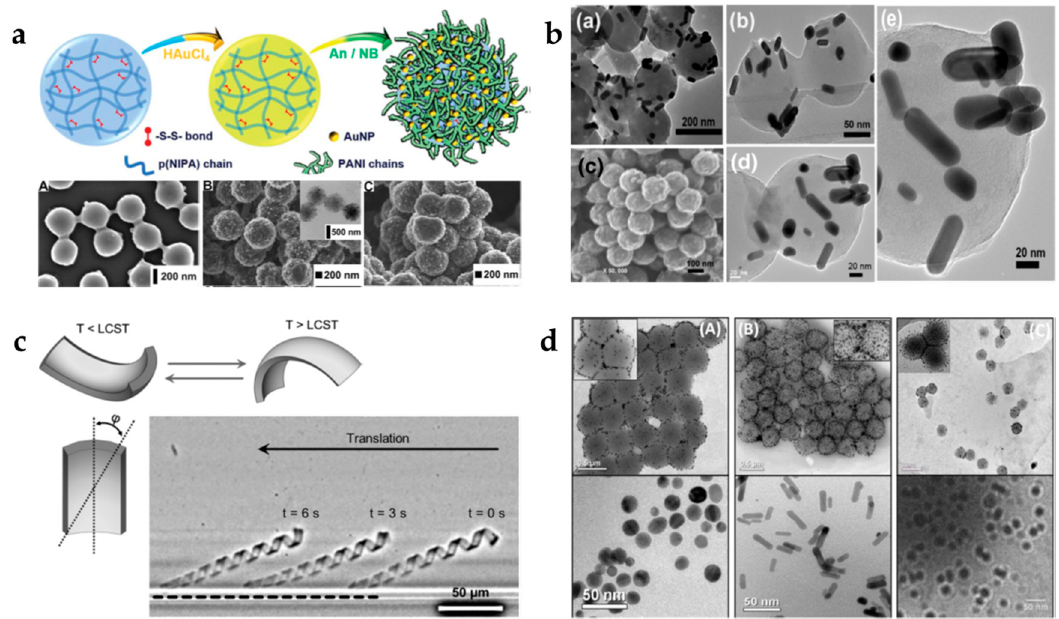
Figure 5. ( a ) Scheme for the preparation of PNIPAAm microgels, polyaniline (PANI) fibers and AuNPs microcomposite and the respective scanning electron microscopy images (Reproduced from ref. [106]. Copyright 2016 The Royal Society of Chemistry); ( b ) Transmission electron microscopy images of hybrid microgel particles composed of PNIPAAm microgels and AuNRs. (a,b,d,e) The figure show spherical microgels with a rough surface with Au NRs attached; (c) Field emission scanning electron microscopy image of hybrid microgels (Reproduced from ref. [107]. Copyright 2013 John Wiley and Sons); ( c ) Schematic illustration of the helix direction controlled by the principle curvatures 1/R1, 1/R2 and the mismatch of ϕ toward the length axis of the ribbon. Directing the rotational motion to a linear translocation when the oscillating helix is confined close to a flat wall that impedes the rotation around the axis normal to the helix direction. The helix contour length is 160 µ m, the dashed line indicates the wall position (Reproduced from ref. [108] Copyright 2015 John Wiley and Sons); ( d ) Transmission electron microscopy images of (A) PNIPAAm-Au nanospheres (B) PNIPAAm-AuNR and (C) PNIPAAm-Ag nanospheres [109] (Reprinted from ref. [109]. Copyright 2017 Elsevier).